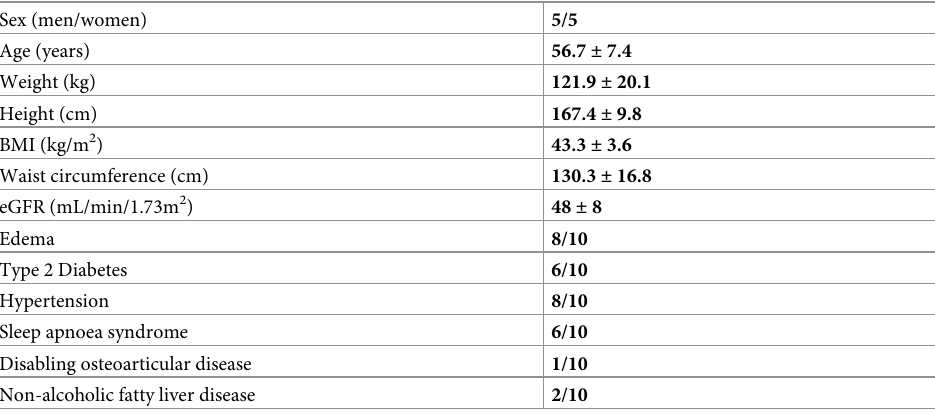
Table 1. Characteristics of the participants at baseline (n = 10).